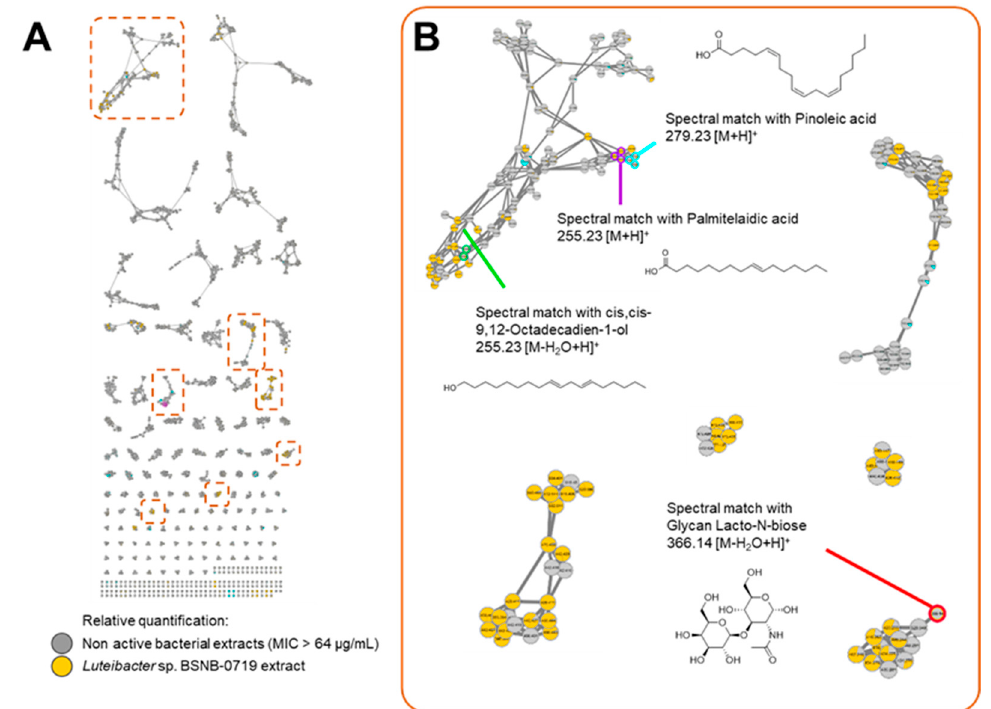
Figure 2. ( A ) Molecular network of the 66 extracts from bacterial endophytes. Relative quantification values of each ion within the extracts are represented as a XIC area-dependent pie chart. ( B ) Clusters of ions from the active extracts of Luteibacter sp. BSNB-0721.